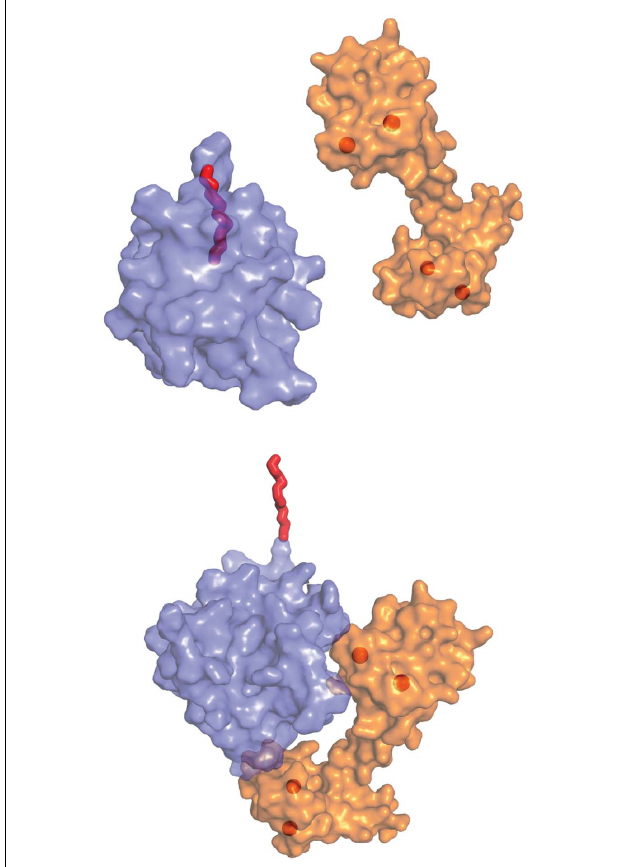
FIGURE 5 | CaM-binding to MA triggers myr exposure. Surface representation of CaM (orange) and myr( + )MA (slate) with the myr group (red) sequestered and exposed in the free and bound states, respectively. Spheres represent Ca 2 + ions.